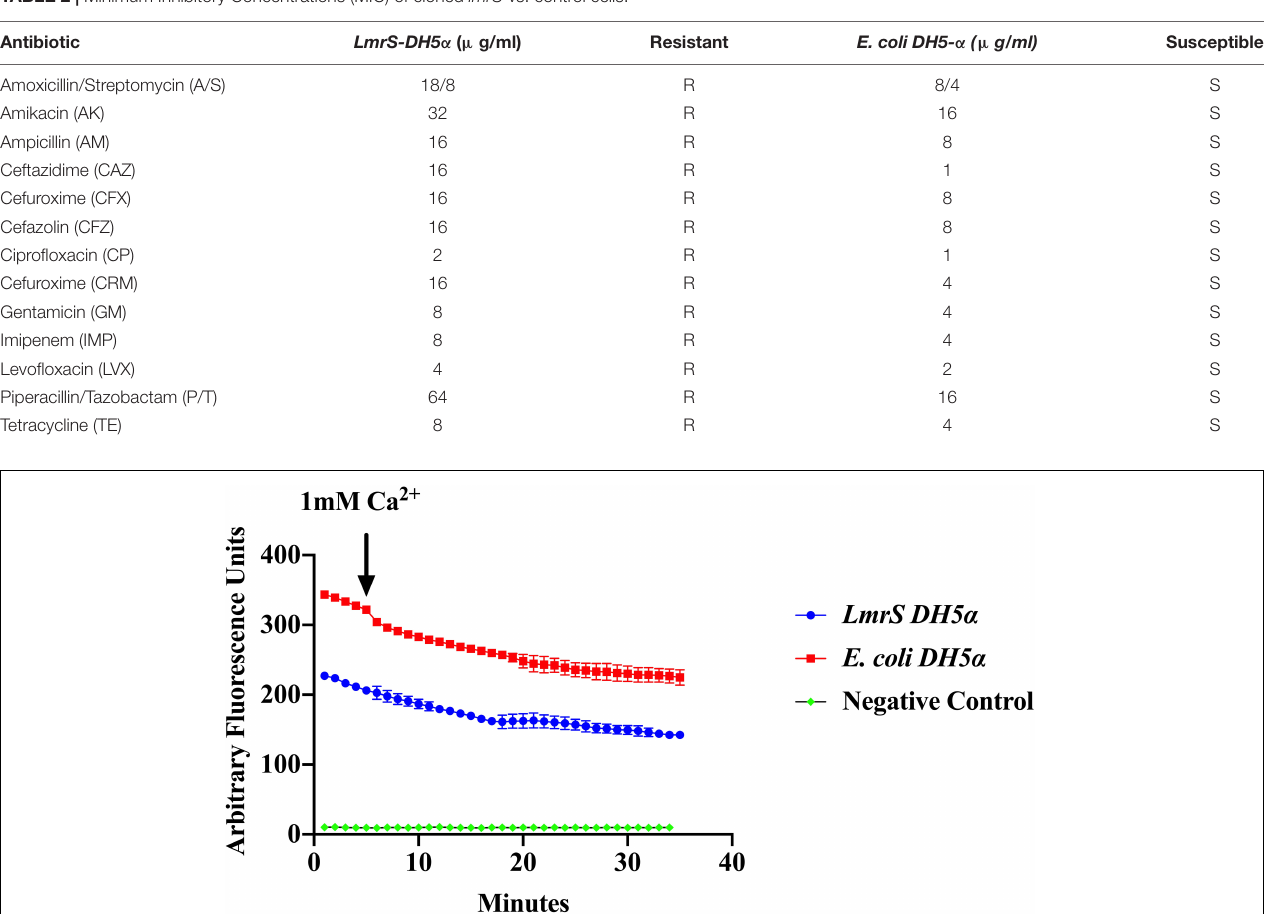
FIGURE 6 | Ethidium bromide efflux measurements in E. coli DH5 α cells carrying the lmrS gene. Direct measurements of EtBr assays in E. coli cells carrying the lmrS gene and cells without lmrS gene (control) were conducted as described in “Materials and Methods.” The results show that the addition of 1 mM CaCl 2 enhances efflux of EtBr in the cloned LmrS, indicated by the lower fluorescence values as well as cells without the cloned lmrS gene. Control cells contained no EtBr. Results show the mean of three independent biological replicates. A Kruskal–Wallis test was utilized to detect significant differences in efflux between the E. coli DH5 α wild-type and the E. coli recombinant strain ( p <